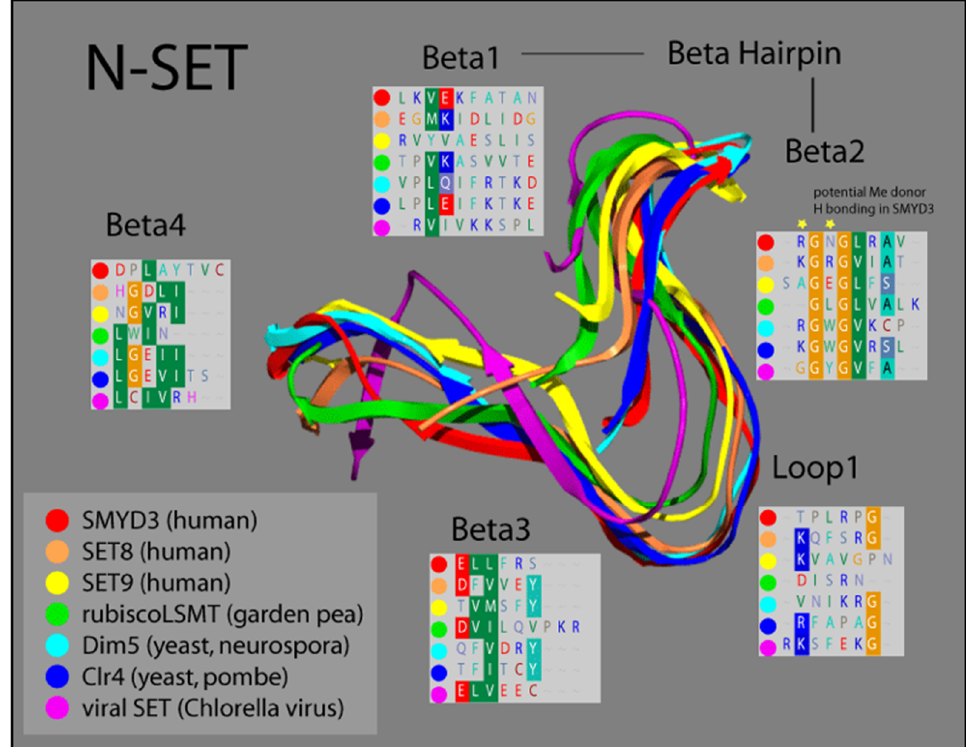
Figure 2. Ribbon model of N-SET regions of various SET Domain-containing enzymes. Colors correspond to individual ribbons from different sources sharing the SET-domain protein motifs. Residues in the panels (Beta1-4 and Loop1) correspond to the specific residues in each structural element, highlighting the homology in this region [16,17].